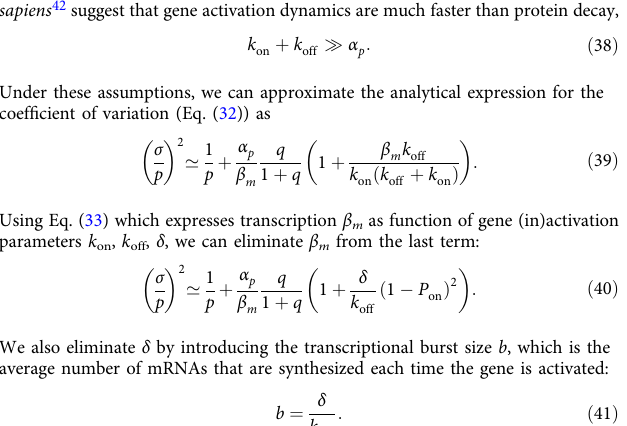
f ′ ( p * ) = 0 since f ( p ) reaches its optimum f max at p = p * . f ″ ( p * ) is the curvature of the fi tness function at its maximum. It is a negative number which characterizes how narrow the fi tness function is. Because protein abundance fl uctuates around p * , the cell doesn ’ t experience the maximum fi tness f max but rather a lower average fi tness f h i . Averaging F over fl uctuations in protein abundance, we obtain (cid:4) (cid:5)(cid:10) (cid:6) þ 1 ¼ f F p ; β m f ′′ p (cid:2) ð Þ σ 2 (cid:3) c m l m β m max 2